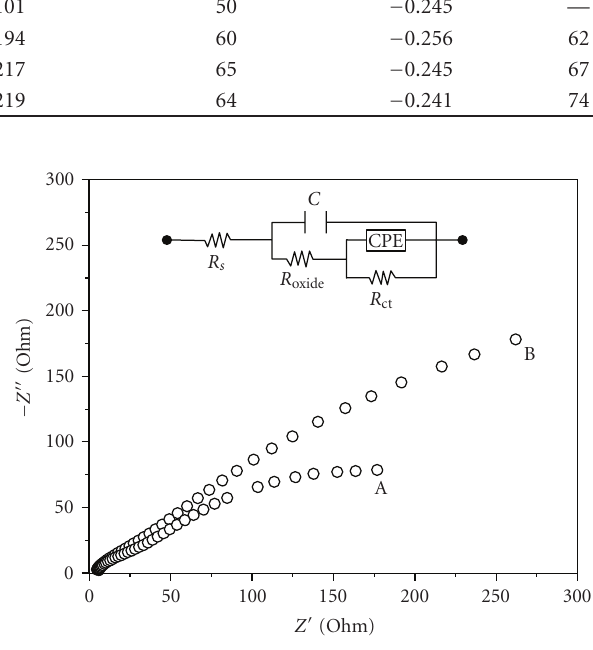
Table 1: Results of Tafel slope analysis of the polarization plots at 298K.